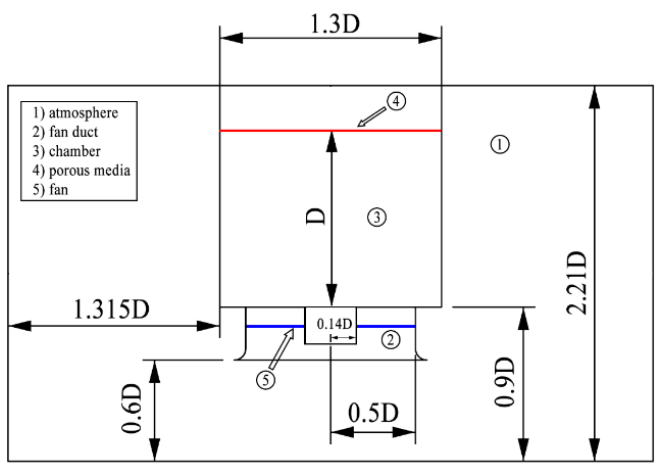
Figure 2. Front view of the numerical domain.